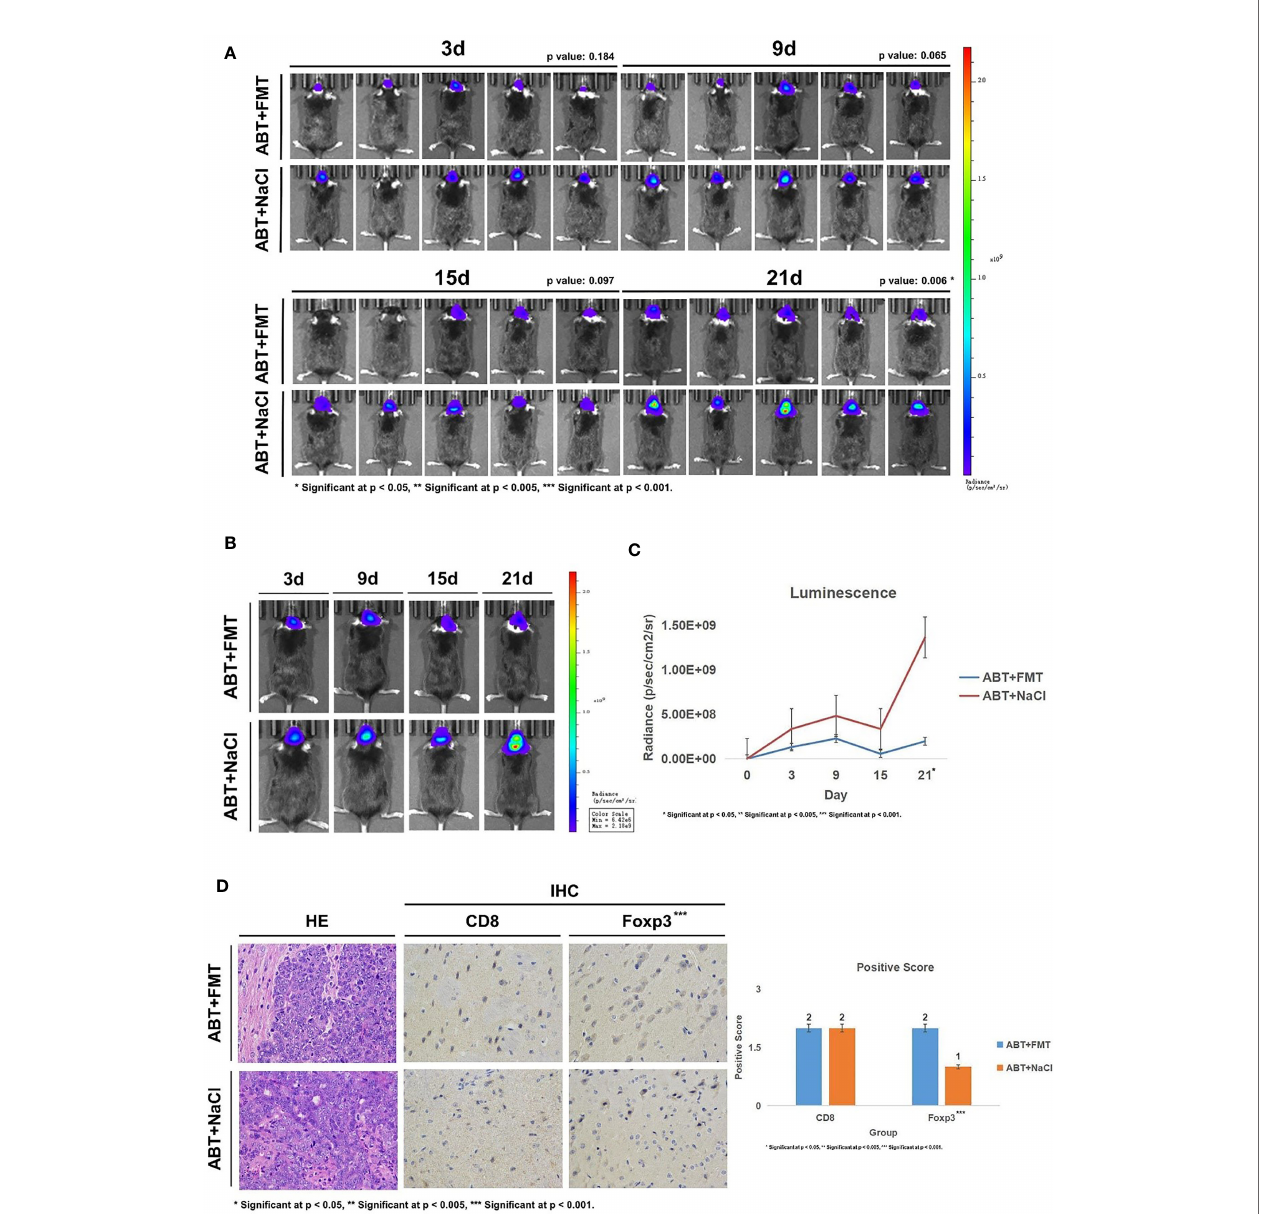
FIGURE 5 | (A) Living image results of glioma tumor growth in mice (n = 5). Living image was performed on mice at 3, 9, 15, and 21 days of glioma growth. ABT +FMT: fecal microbiota transplantation after antibiotic treatment. ABT+NaCl: intragastric administration with physiological saline after antibiotic treatment. (B) Living image results of glioma tumor growth in mice (n = 1). Living image was performed on mice at 3, 9, 15, and 21 days of glioma growth. ABT+FMT: fecal microbiota transplantation after antibiotic treatment. ABT+NaCl: intragastric administration with physiological saline after antibiotic treatment. (C) Luminescence curve of glioma in living image (n = 5). ABT+FMT: fecal microbiota transplantation after antibiotic treatment. ABT+NaCl: intragastric administration with physiological saline after antibiotic treatment. (D) The expressions of CD8 and Foxp3 in the ABT+FMT group and ABT+NaCl group were detected by immunohistochemistry (×400 magni fi cation). *Signi fi cant at p < 0.05, **Signi fi cant at p < 0.005, ***Signi fi cant at p <